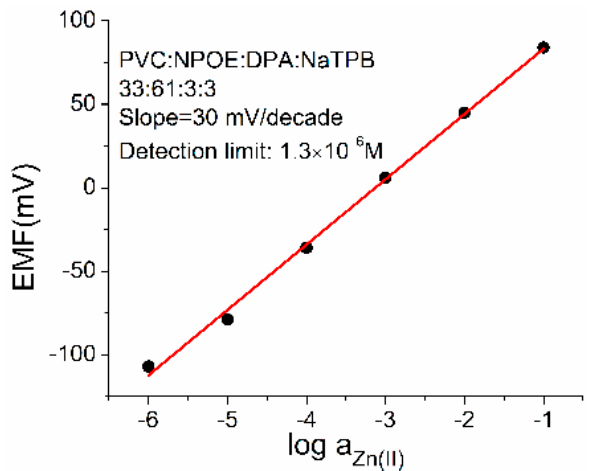
Figure 4. Potentiometric characteristics calibration curve for Zn 2+ selective sensor based on DPA.